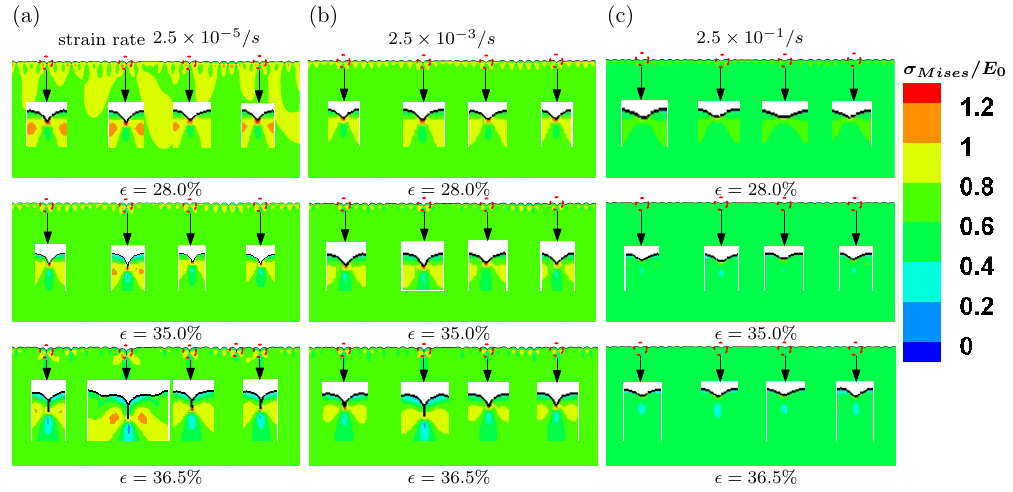
Figure 10. Evolution of surface morphology for a three-layer model at three levels of strains with different imposed strain rates. ( a ) 2.5 × 10 − 5 /s; ( b ) 2.5 × 10 − 3 /s; ( c ) 2.5 × 10 − 1 /s.